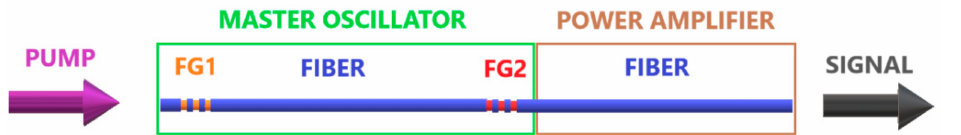
Figure 6. Schematic diagram of a master oscillator power amplifier chalcogenide glass fiber laser proposed in [32].